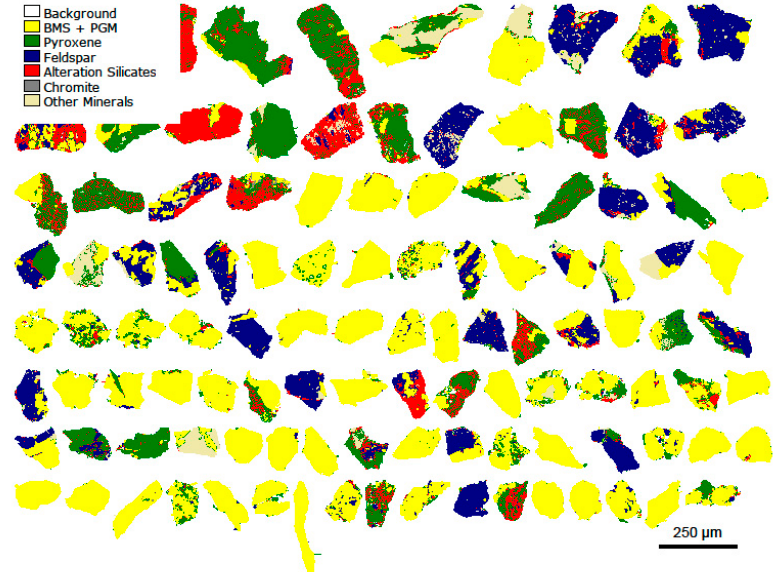
Figure 17. MLA false-color images of the various mineral particles in the nitric acid-washed concentrate. The first column shows the liberated platinum-group minerals, the second column some examples of sulphides and associated platinum-group minerals, and column 3 illustrates some of the silicate and oxide minerals (some still with associated sulphides).